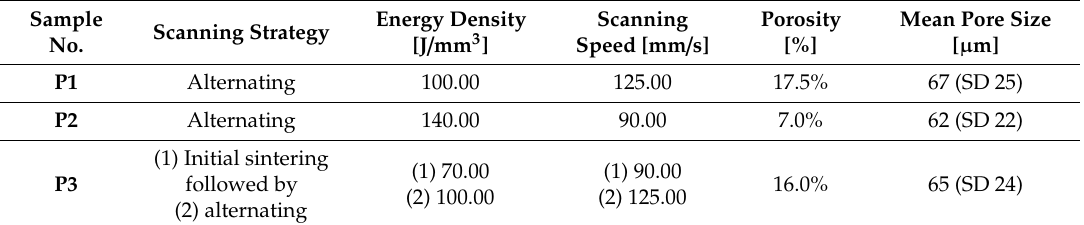
Table 1. Porosity measurements by means of computer microtomography. SD is the value of the standard deviation of